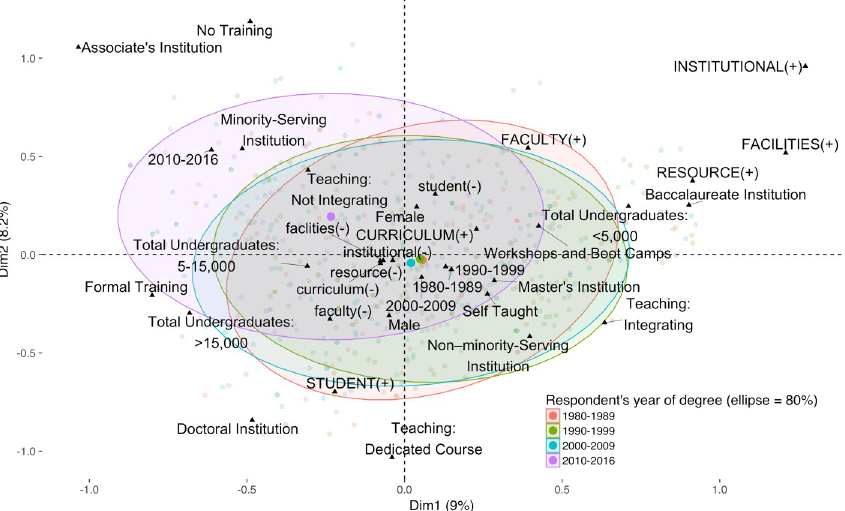
Fig 5. Multiple correspondence analysis of responses stratified by year of highest degree. Multiple correspondence analysis allows categorical data to be visualized in a manner similar to the way in which principle component analysis is used for numerical data. Here we display several demographic categories of survey respondents in one figure. A sampling of individual respondents (pale colored dots) are grouped in a colored ellipse encompassing 80% of the respondents in one of four cohorts defined by the decade in which they earned their highest degree (see key); an ellipse is centered on a bold colored dot that represents the average location of all the respondents in that cohort. In the figure, the youngest cohort, terminal degrees earned in 2010–2016, clearly separates from the older cohorts, meaning that the overall experience of this group is different than that of the other three. Only respondents who responded to all the demographic questions are shown ( n = 526). In addition to information about a respondent’s decade of terminal degree, two other types of categorical information are mapped onto the two-dimensional space of the figure.